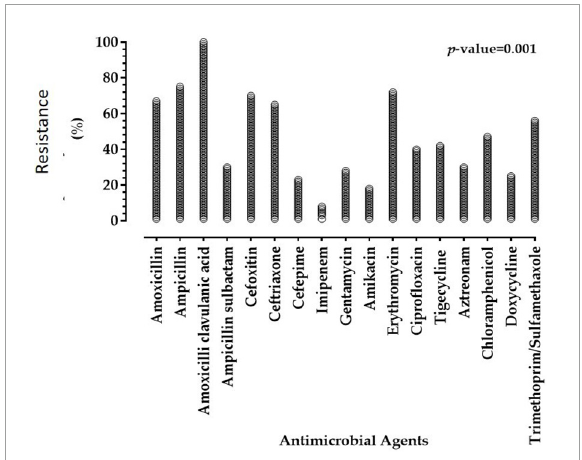
FIGURE1 Resistance of Enterobacterales isolates of animal and human origins to antimicrobial